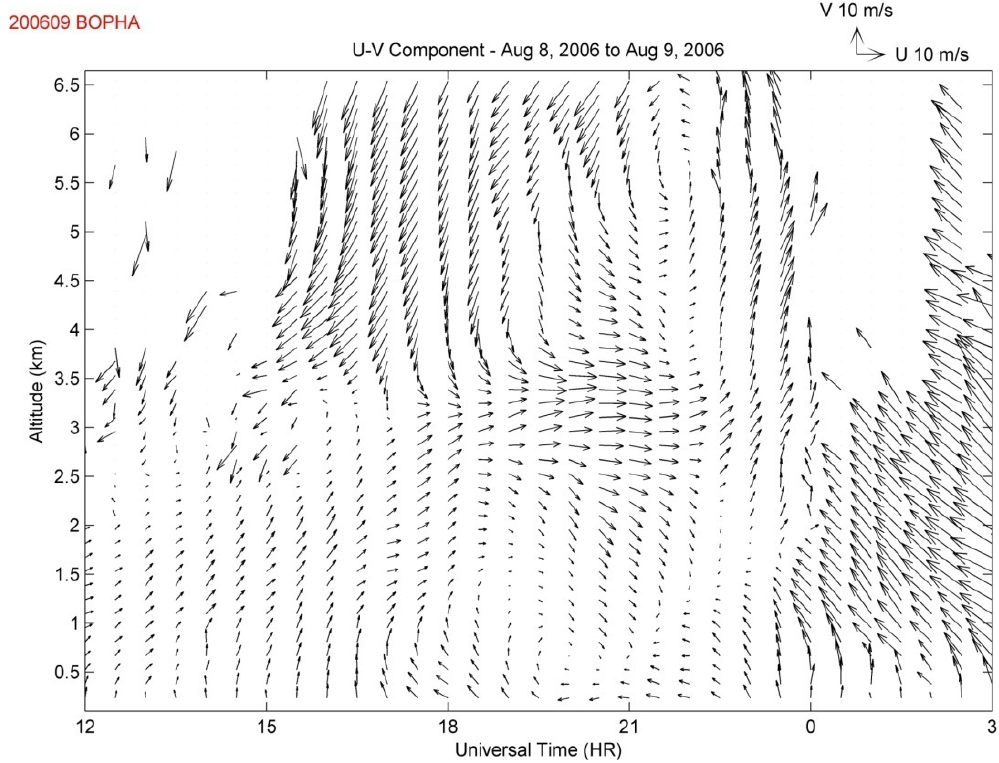
Figure 3. Altitude-time profile of the Horizontal wind observed during the passage of Typhoon Bopha.